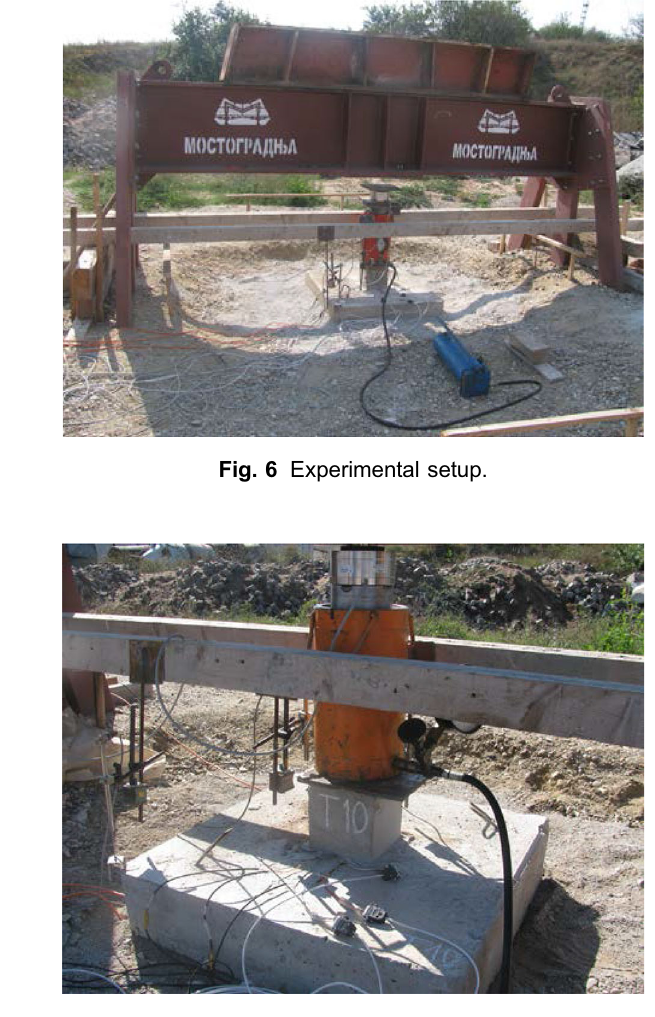
Fig. 7 Experimental setup